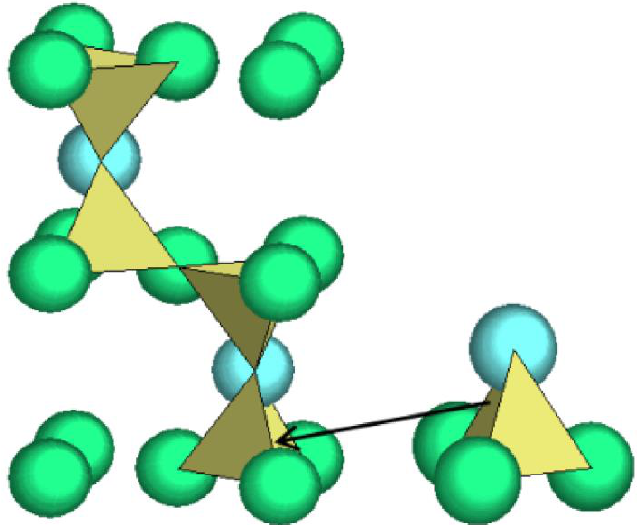
Figure 1. Crystal structure of beta-tridymite using tetrahedral cluster [Si – O 4